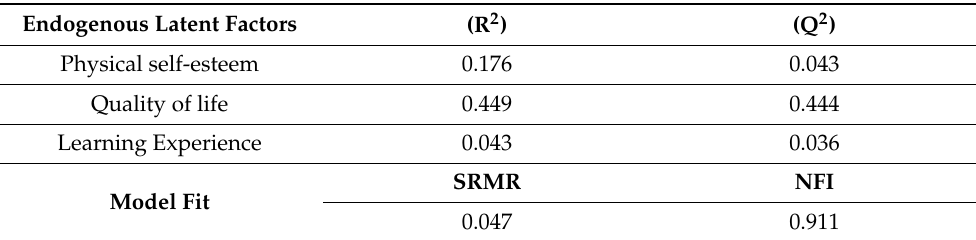
Table 5. Coefficient of determination (R2) and (Q2) and model fit